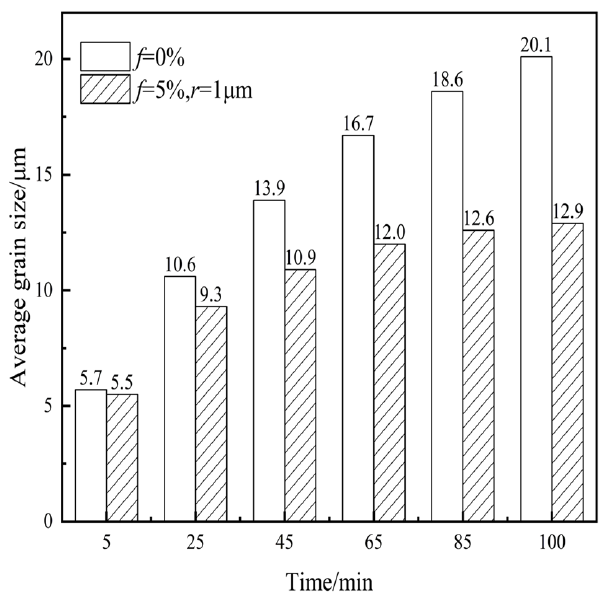
Figure 3. Histogram of average grain size with time with and without SPPs.